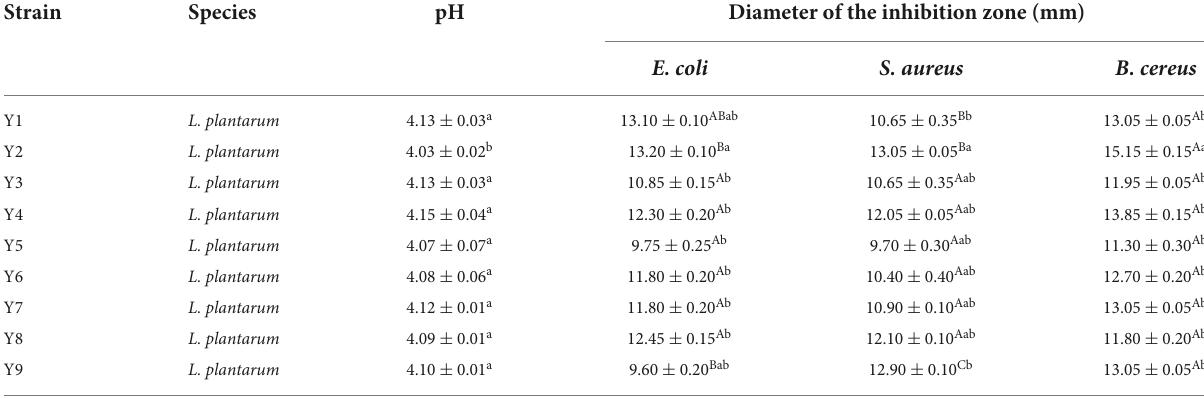
TABLE 1 The pH change and antibacterial activity determination of Ginkgo biloba kernel juice fermented by LAB strains used in this study.